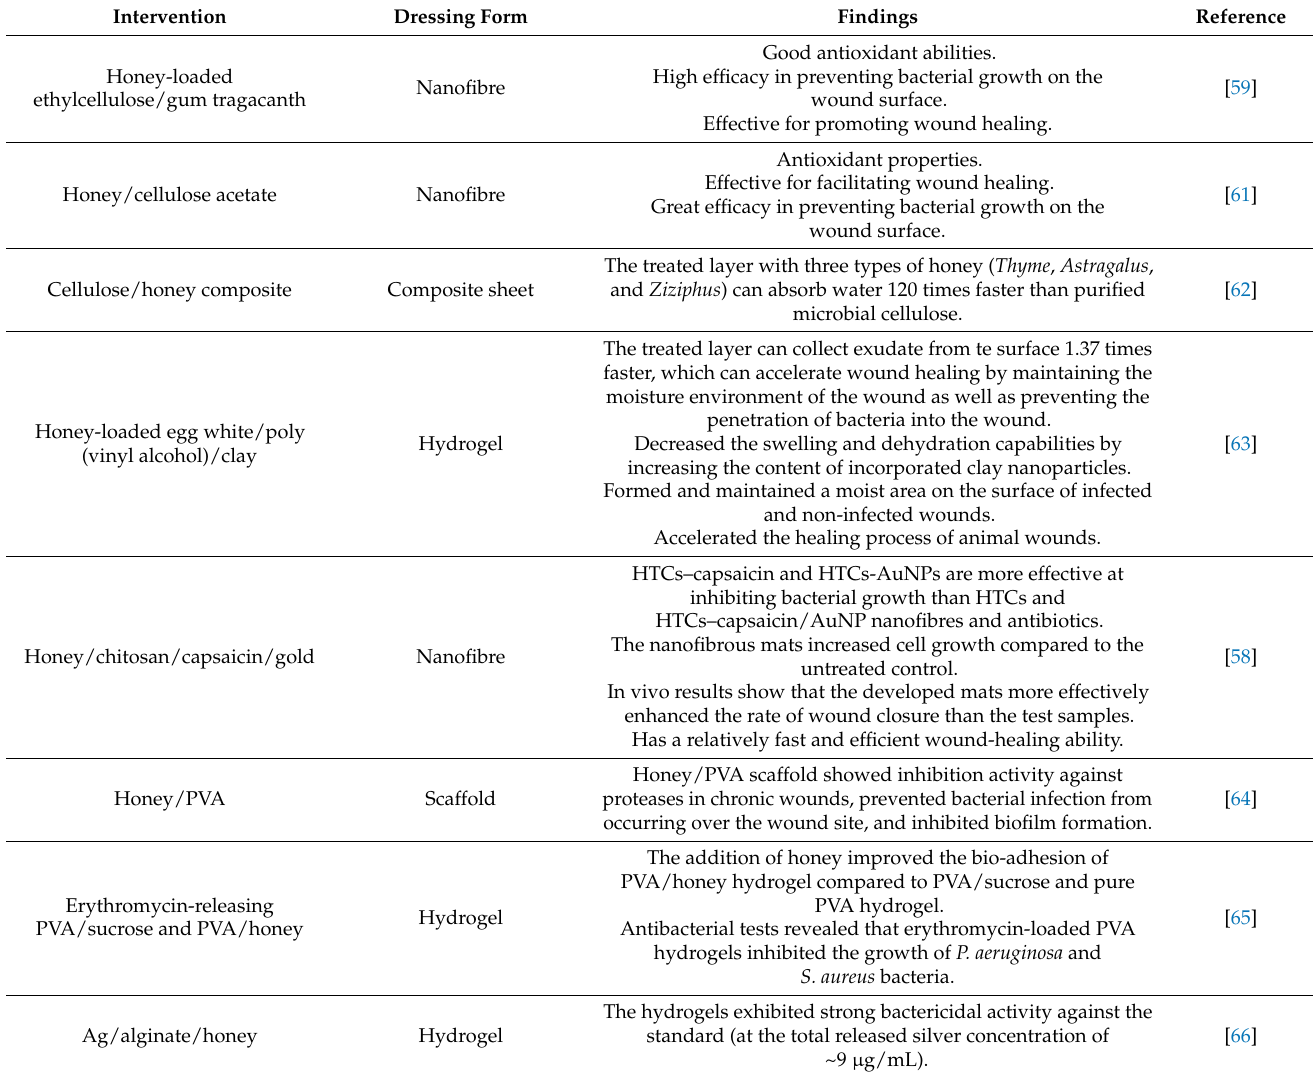
Table 3. Honey-based nanoparticle applications for wound